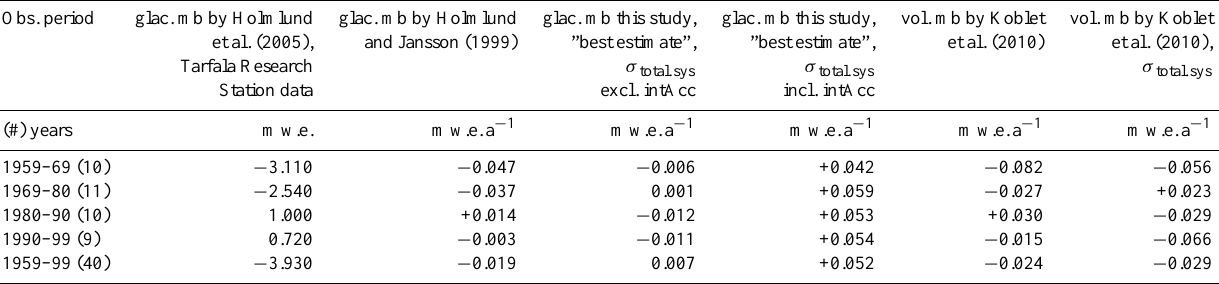
Table 4. “Official” glaciological mass balance (Holmlund et al. (2005), Tarfala Research Station data) in comparison with other glaciological (glac.) and volumetric (vol.) mass balance (mb) series of Storglaci¨aren. The table shows cumulative mass balances of the “official” glaciological data series for the observation periods and corresponding mean annual differences of the other series. Note that the observation periods refer to the start and end year of the corresponding first and last field surveys, respectively, e.g., the period 1959–99 covers the hydrological years from 1959/60 to